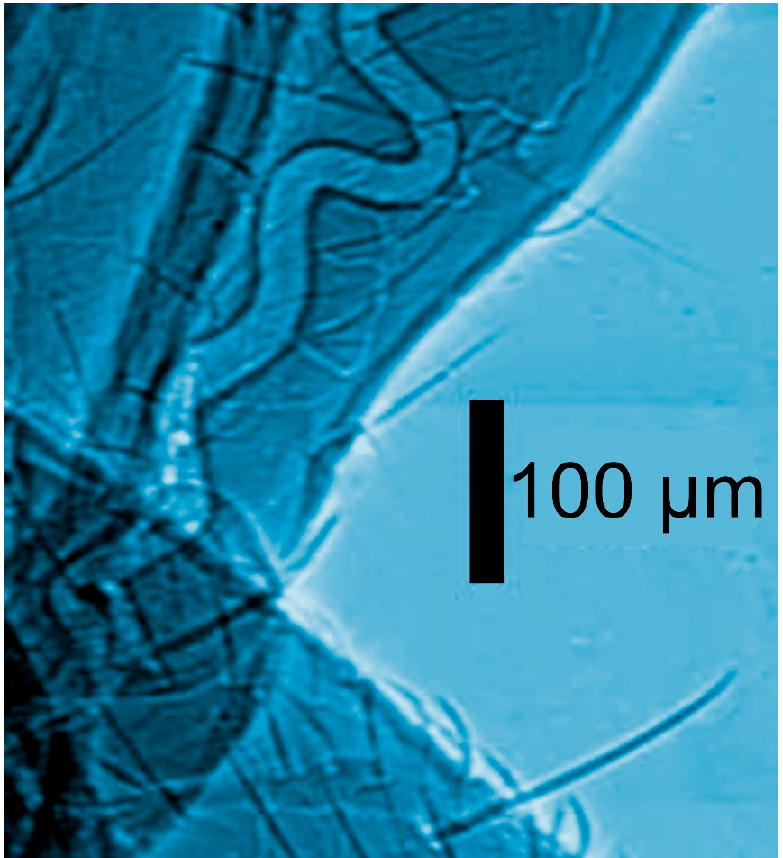
Figure 1. An example of a coherence-based radiograph: the enhanced edges of microscopic vessels in a mouse liver [13]. Horizontal image size: 4.2 mm.